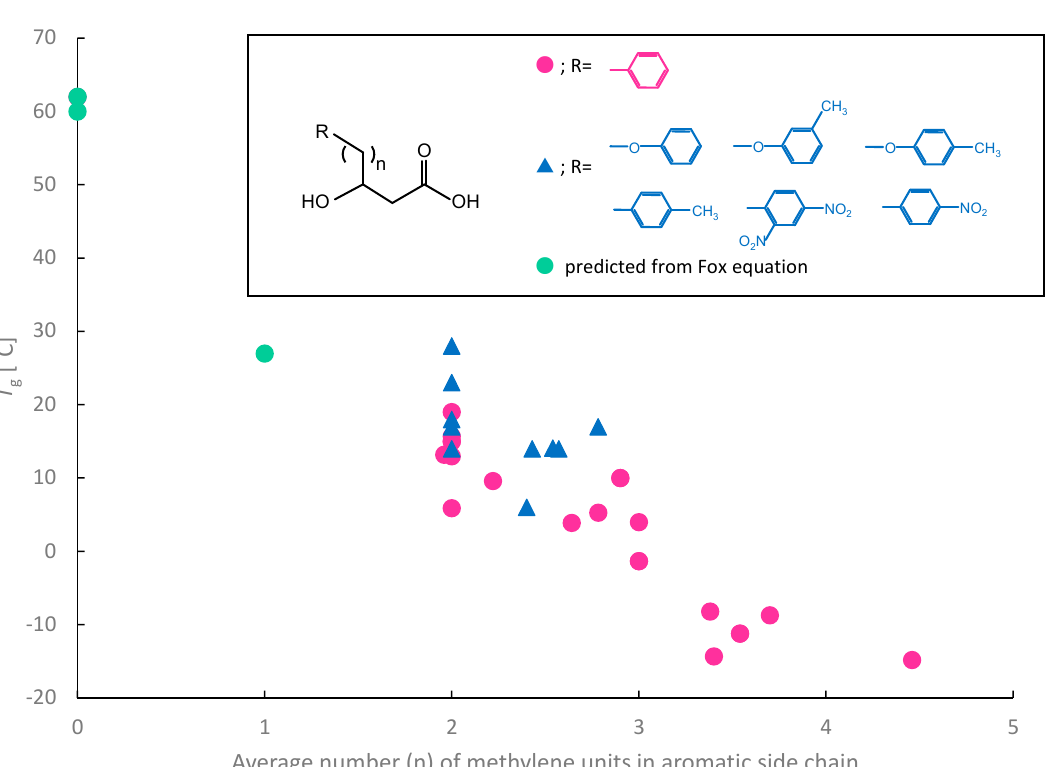
Figure 2. Correlation between T g and average number of methylene units in aromatic side chain. Red circles: T g of aromatic PHAs containing phenyl group; blue triangles: T g of aromatic PHAs containing phenoxy, methylphenyl, methylphenoxy, or nitrophenyl group; green circles: T g predicted from Fox equation. Values are from References [9,14,15,19,26,30,33,38,40,42,44,52,64].